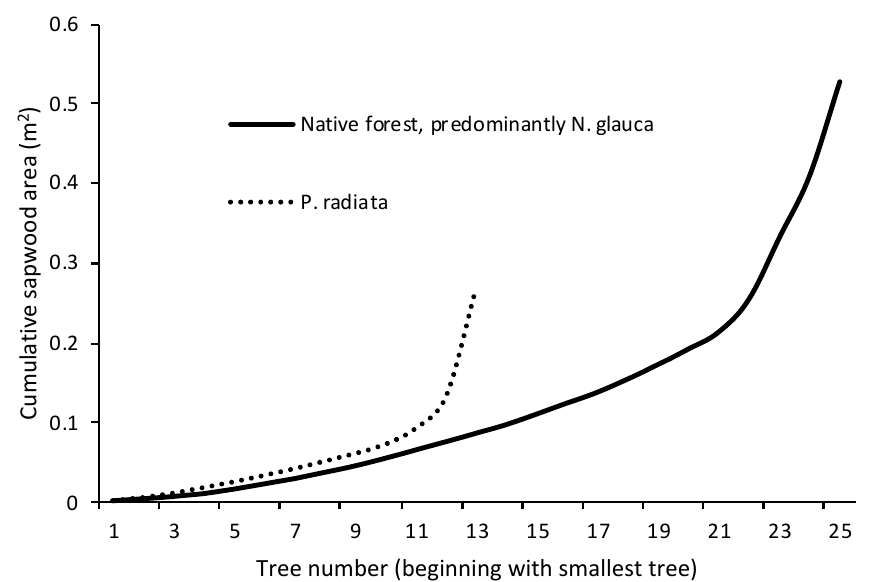
Figure 2. Cumulative sapwood area as a function of tree number, where the trees were sorted from smallest to largest within species. This shows that P. radiata contributed just over one-third of the total stand sapwood area and that in both species about half of the sapwood area was contributed by a small number of large trees.